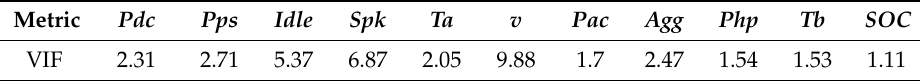
Table 4. Variation inflation factor (VIF) values of the energy consumption rate (ECR)